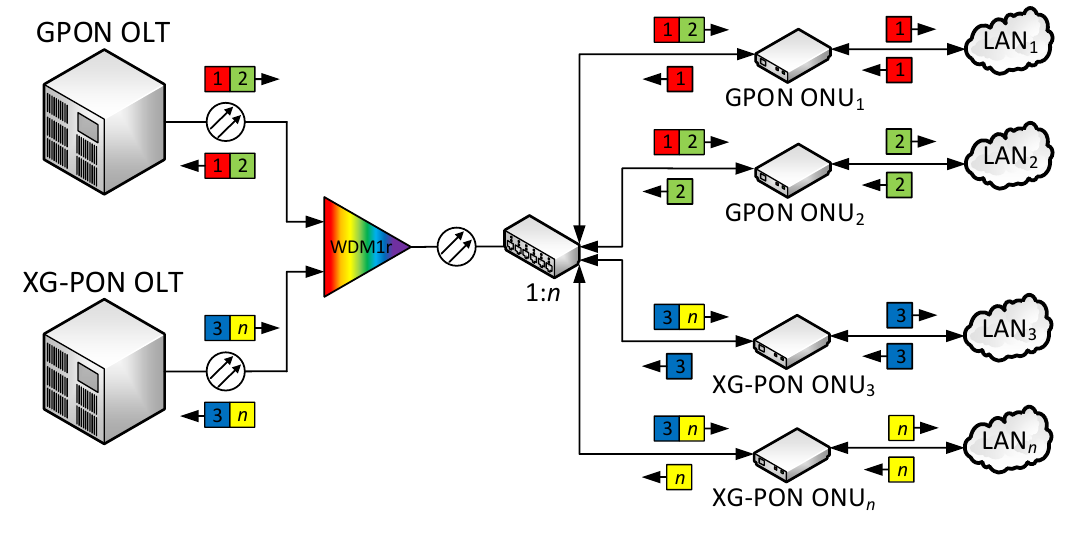
Figure 5. Coexistence scheme of GPON and next-generation PON